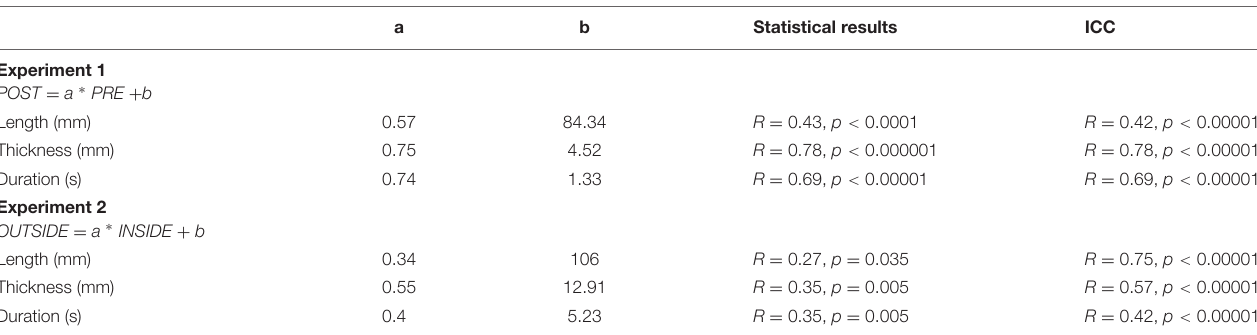
TABLE 1 | Description of the linear regression model and associated statistical